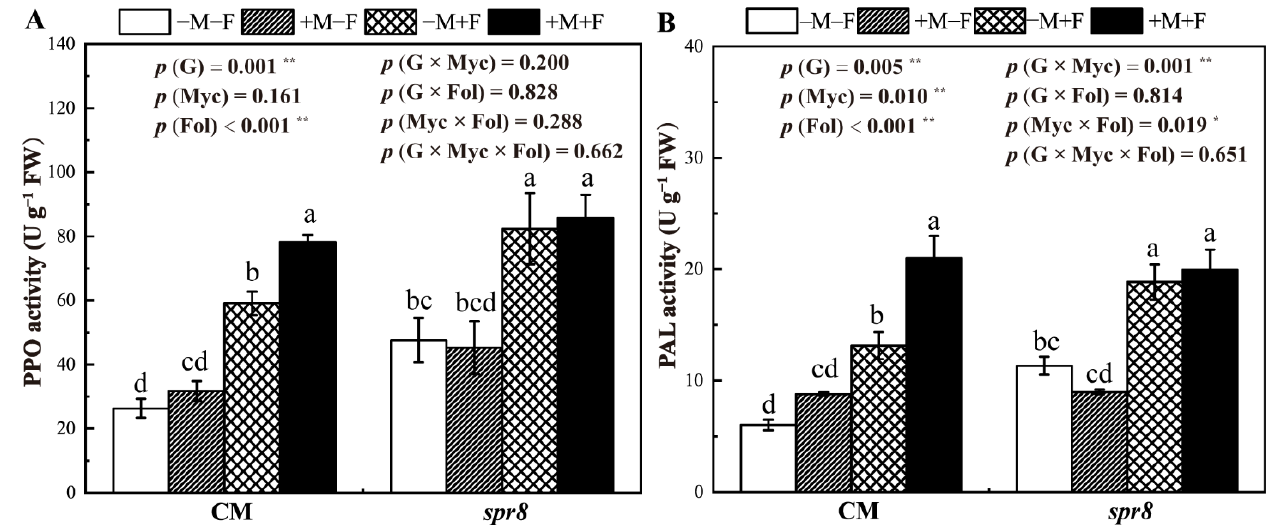
Figure 6. Effects of inoculation with Rhizophagus irregularis inoculation (Myc) and Fusarium oxysporum f. sp. Lycopersici (Fol) on the enzymes activities of polyphenol oxidase (PPO) ( A ) and phenylalnine ammonialyase (PAL) ( B ) of CM and spr8 plants (G). − M and +M represent non-inoculation and inoculation with Rhizophagus irregularis , respectively. − F and +F represent non-inoculation and inoculation with Fusarium oxysporum f. sp. Lycopersici , respectively. Same lowercase letters above the columns indicate non-significant difference ( p < 0.05) between corresponding treatments. *— p < 0.05; **— p <